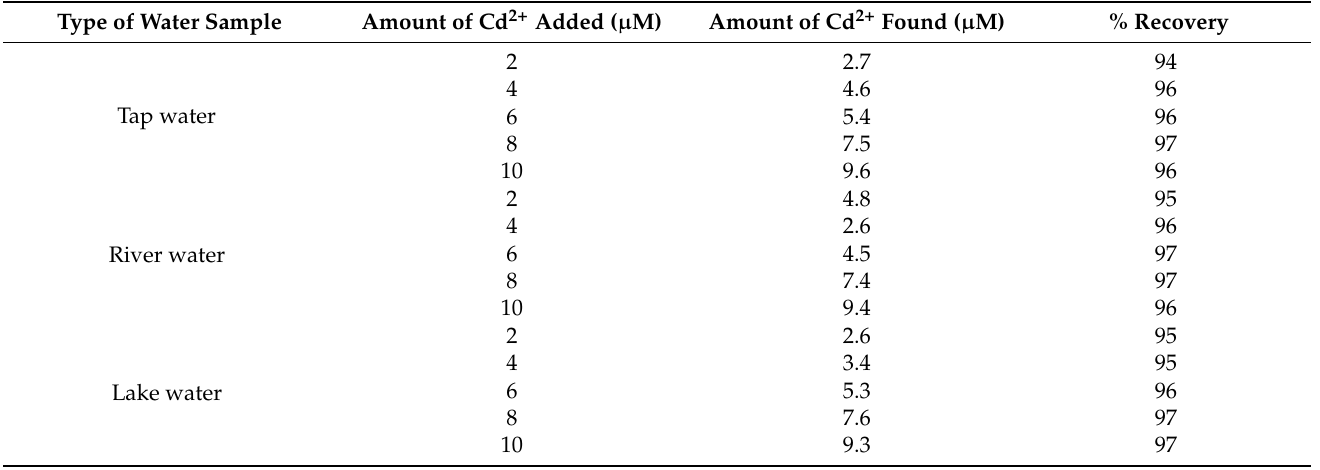
Table 1. Natural water samples spiking analysis using CM1 (10 µM) and Cd 2+ ion (2–10 µM) range. Type of Water